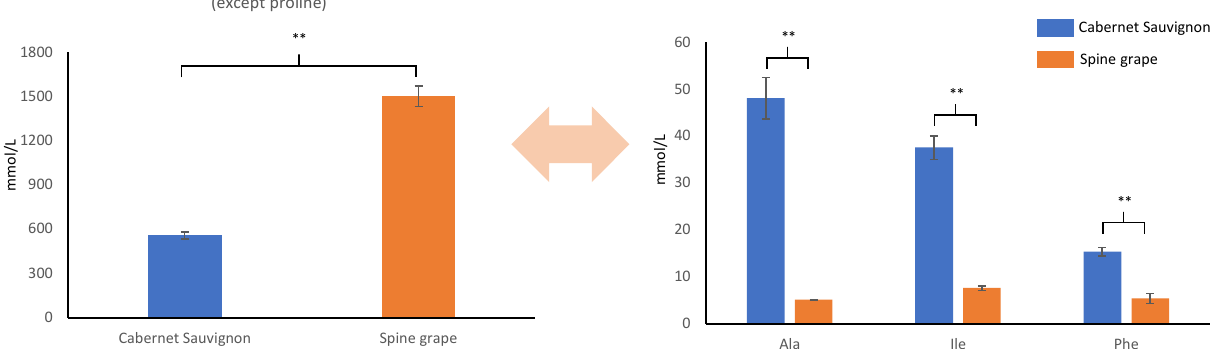
Figure 1. Concentrations of total amino acid (except proline), alanine, isoleucine, and phenylalanine in Cabernet Sauvignon and spine grape must. Difference significant at 99% (**) confidence level.